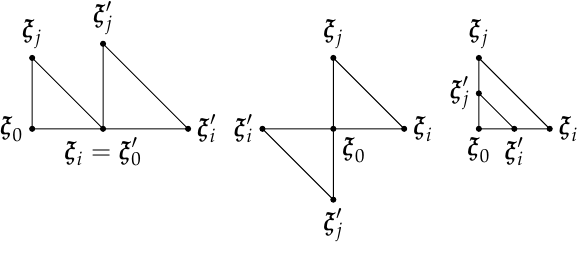
Figure 2. Graphical representation of the simplex translation, rotation and shrinking simplex operations for three points in R 2 . The initial vertex set is V = { ξ 0 , ξ i , ξ j } , and the final vertex set is V (cid:48) = { ξ (cid:48) 0 , ξ (cid:48) i , ξ (cid:48) j } . The three operations produce similar